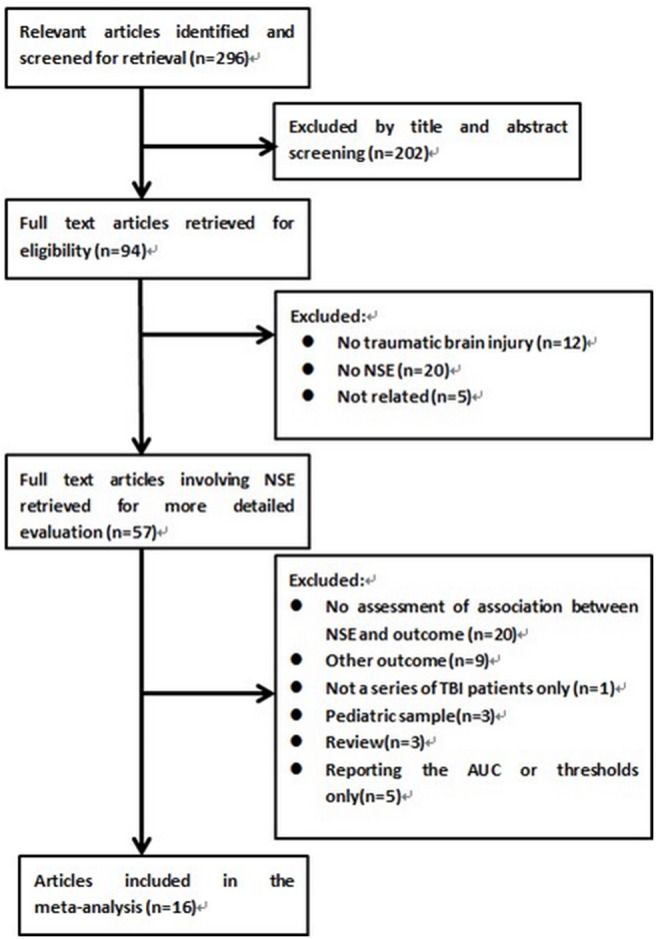
Identification process for eligible studies.Of the 296 studies initially identified from our electronic search, 16 met the inclusion criteria and were included in this meta-analysis.